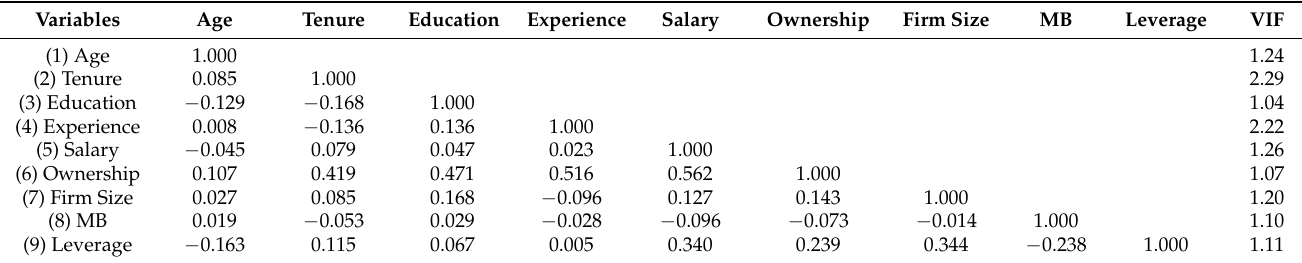
Table 4. The results of the tests of multicollinearity.